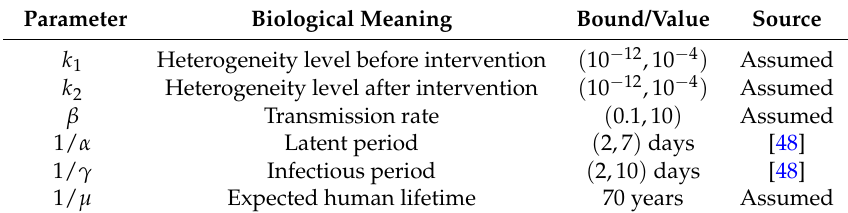
Table 1. Parameter notations, biological meanings, values and sources.